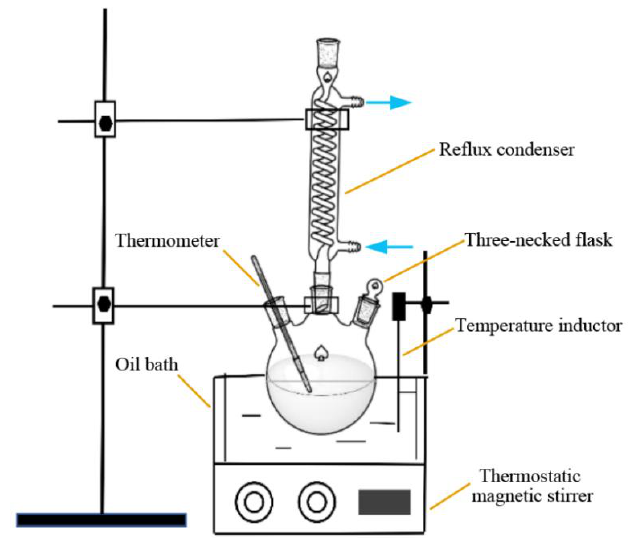
Figure 2. A schematic diagram of the apparatus used for the acid leaching tests.